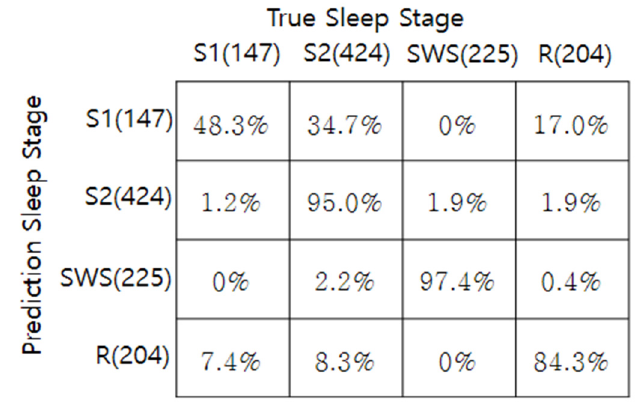
Figure 6. Confusion matrix of the classification results (Exp2). Exp3 verifies the classification accuracy using EEG and EOG images in the time and frequency domains. The input for the CNN in Exp3 was resized by concatenating the images that were used in Exp1 and Exp2. Figure 7 shows the accuracy of the experiment for numbers of epochs. After 14 epochs, the CNN achieved a 98% training set accuracy and a 94% validation set accuracy.